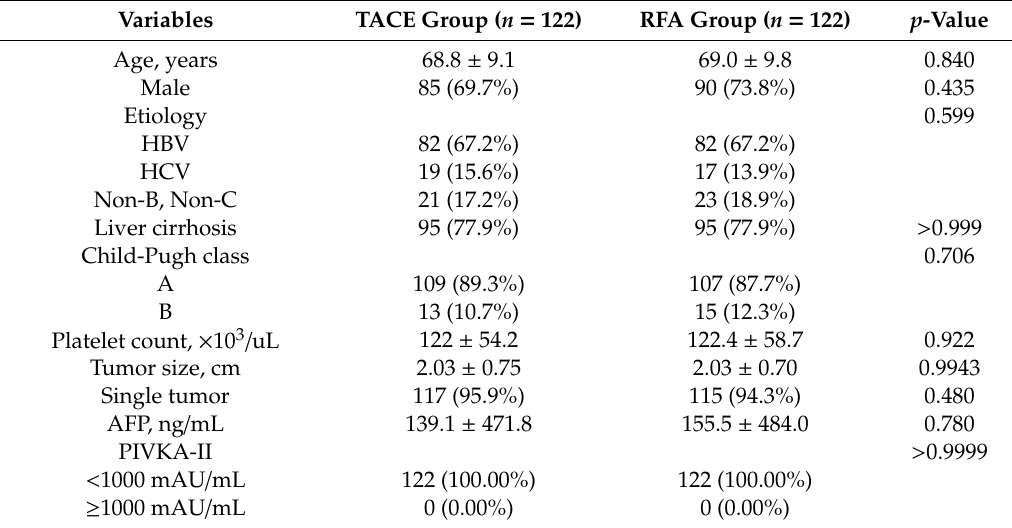
Table 3. Comparison of baseline clinical characteristics between the two groups after adjustment using propensity score